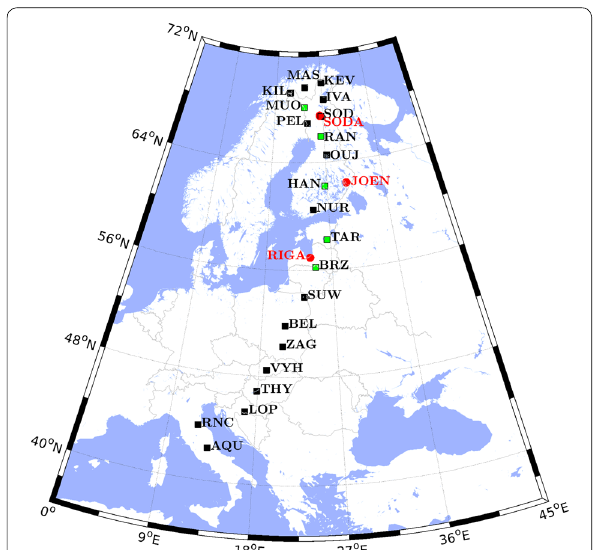
Fig. 1 Map of the EMMA stations (square markers) used for the plasmasphere analysis. Green squares identify the station pairs used to describe in detail the plasmasphere dynamics at three different latitudes. Red circles are the positions of the global navigation satellite system receivers nearest to the considered station pairs and used for the ionospheric analysis described in “Ionospheric response in terms of vertical, top, and bottom TEC.” Coordinates are geographic. See Table 1 for additional info about the EMMA stations used in the